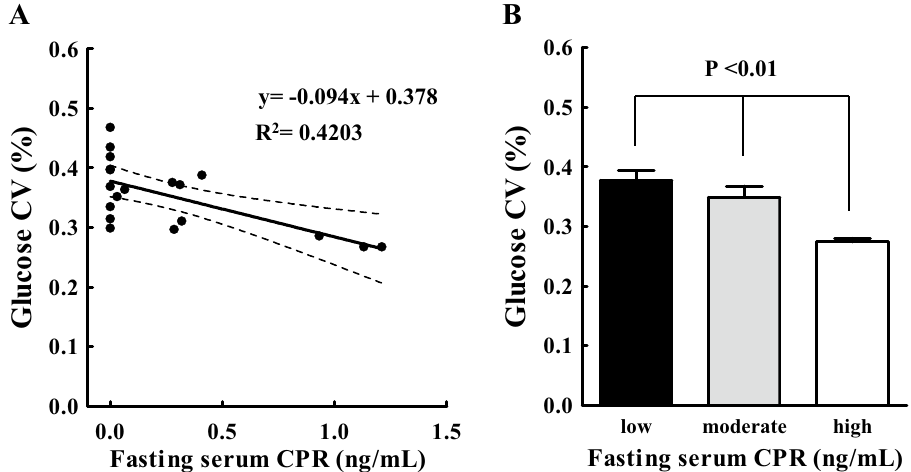
Figure 5. ( A ) Scatterplot indicating the relationship between fasting serum CPR (x-axis) and glucose CV (y-axis) measured within 120 days from baseline. The solid line is the line of best fit from linear regression analysis. The dashed band is the 95% confidence band of the line of best fit. ( B ) Fasting serum CPR levels are divided into three groups: < 0.1 ng/mL (low), > 0.1 ng/mL and < 0.6 ng/mL (moderate), and > 0.6 ng/mL (high). Glucose CV was measured within 120 days from baseline. Glucose CV among different levels of CPR groups was tested using the Jonckheere–Terpstra trend test. A trend toward lower glucose CV with higher serum CPR (p < 0.01) is noted. CPR C-peptide, CV coefficient of variation, R 2 coefficient of